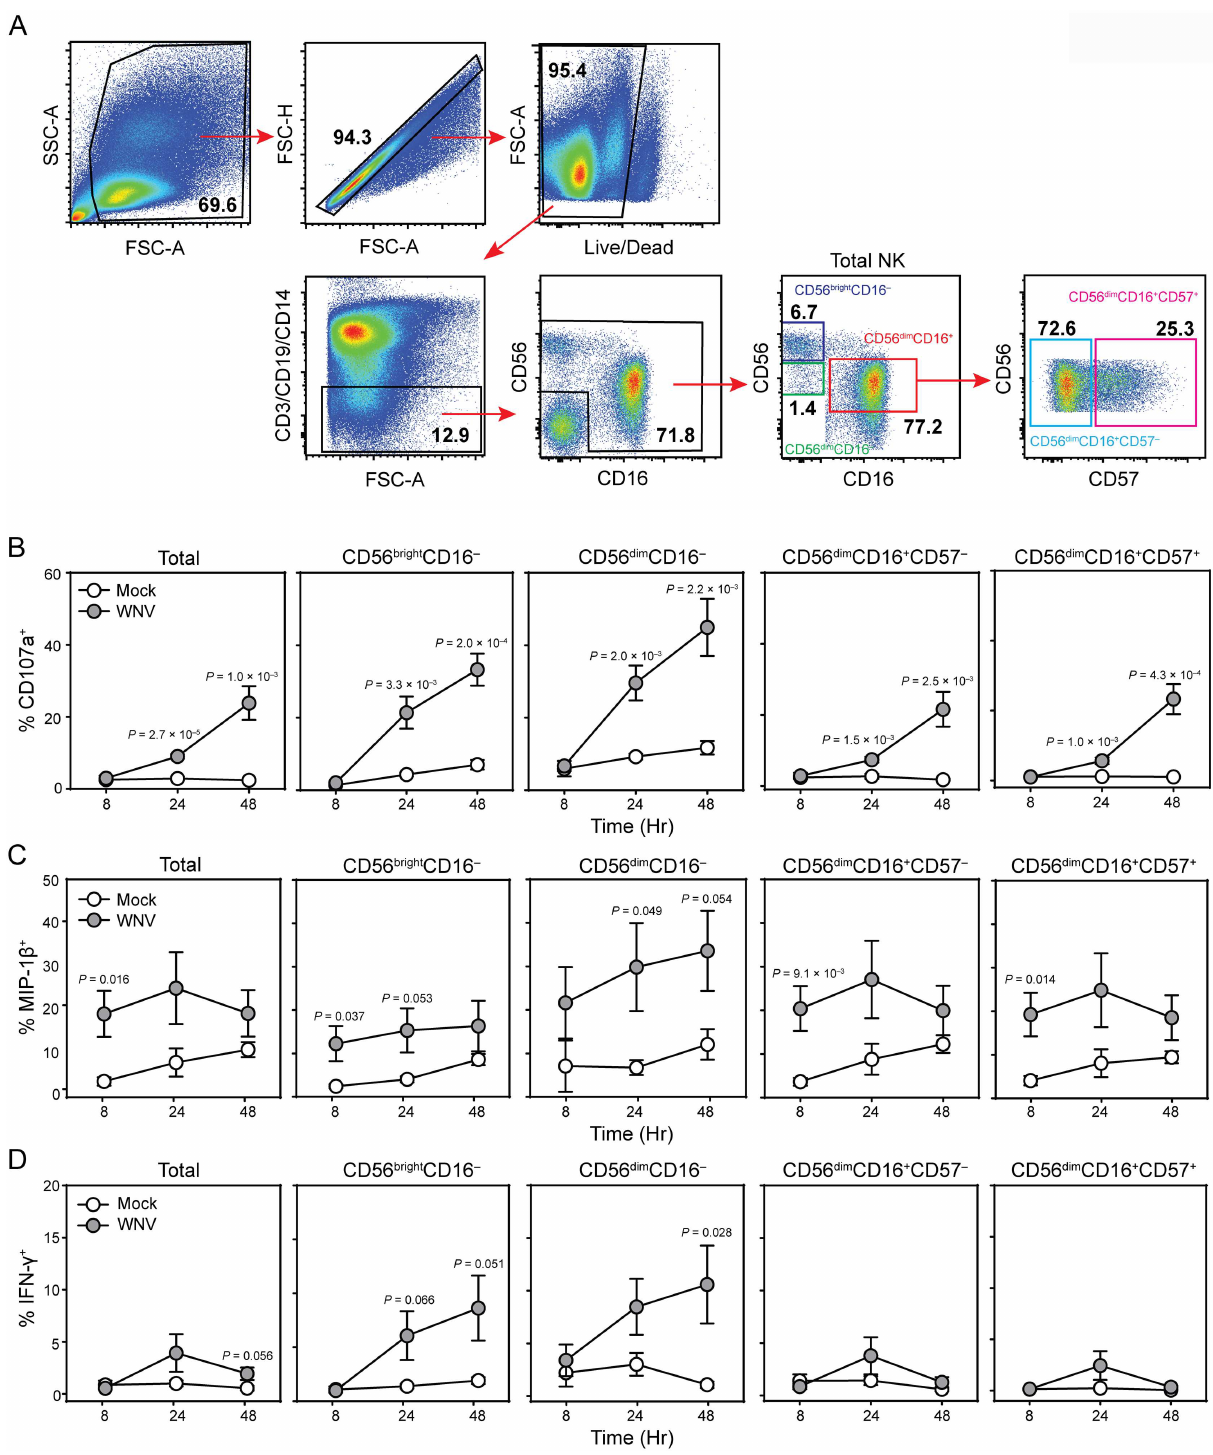
Fig 1. Human NK cell subsets respond to infection with WNV in a time-dependent manner. PBMCs from healthy youngsubjects (n = 6) were incubatedwith medium alone (mock) or infected with WNV (MOI = 1) for 8, 24, and 48 h. The sampleswere labeledwith fluorescence- conjugated antibodiesagainstCD3, CD19, CD14, CD56, CD16and CD57 and analyzedby flow cytometry. (A) Manualgating strategy to define NK cell subsets. Total NK cells, CD56 bright CD16 - , CD56 dim CD16 - , CD56 dim CD16 + CD57 - , and CD56 dim CD16 + CD57 + were assessed for surface expressionof CD107a(B) and intracellularproductionof MIP-1 β (C) and IFN- γ (D). Means ± s.e.m, multiple t tests.